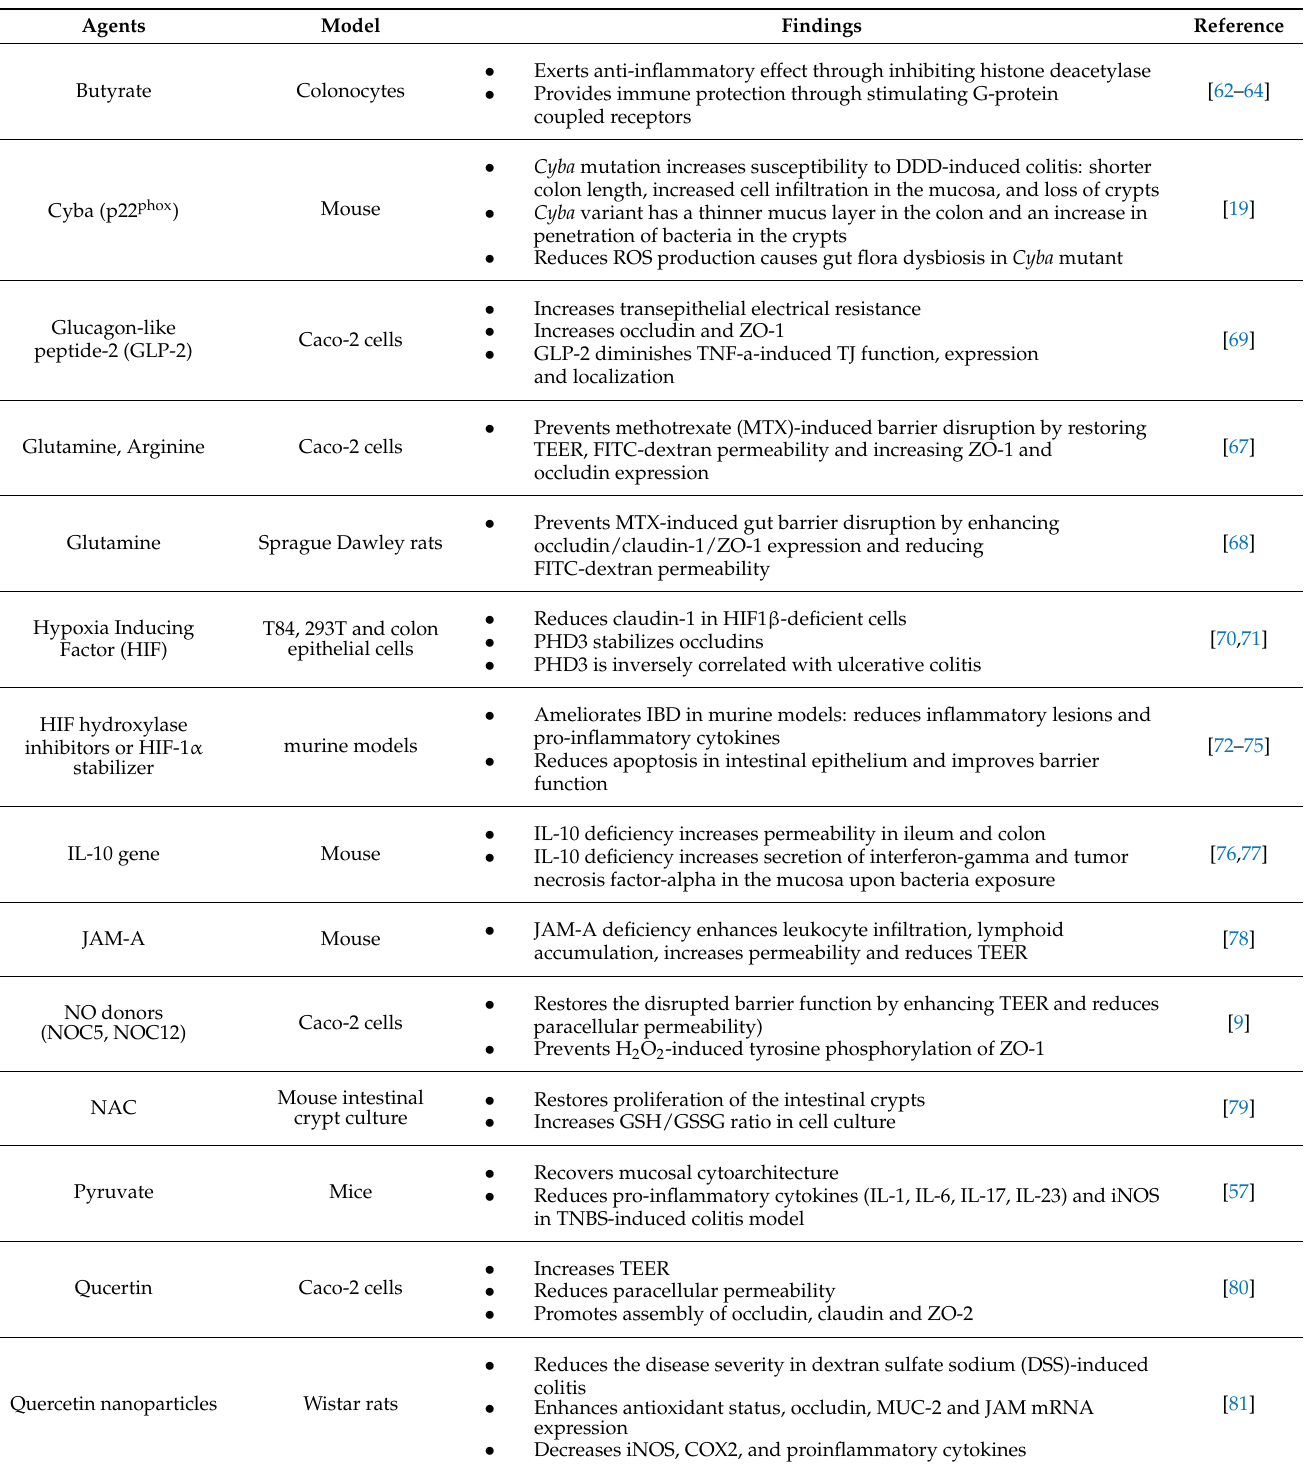
Table 2. Examples of factors that protect the intestinal